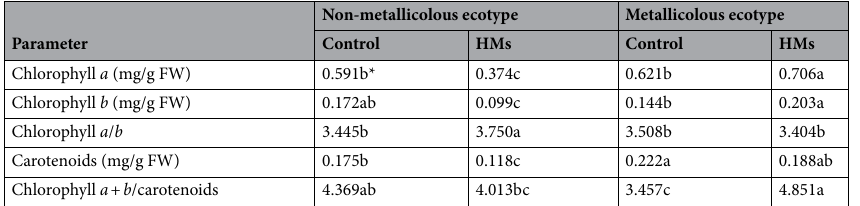
Table 1. Photosynthetic pigments’ content and its ratios in Alyssum montanum shoots cultivated on control medium as well as in the presence of heavy metals (HMs). *Values are means of three replicates. Means indicated by the same letter do not significantly differ at P < 0.05 according to two-way ANOVA and post hoc Tukey’s